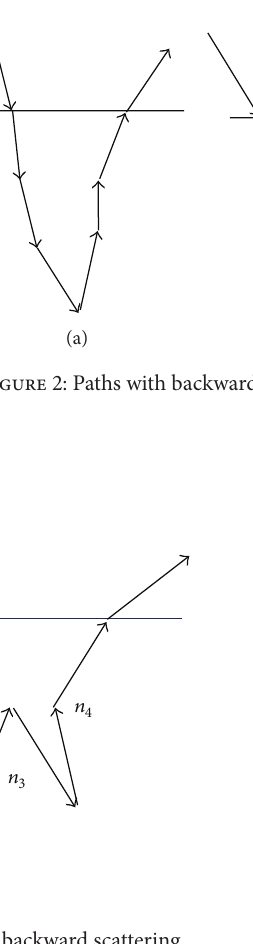
Figure 3: 3-fold backward